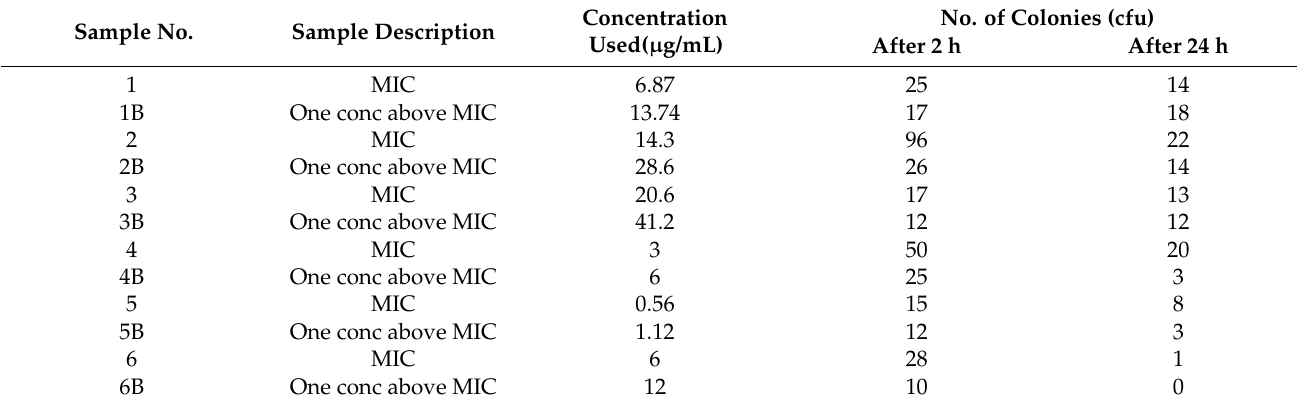
Table 5. Effect of killing time of anise oil-based nanoemulsions against Staphylococcus aureus after 2 and 24 h. Sample